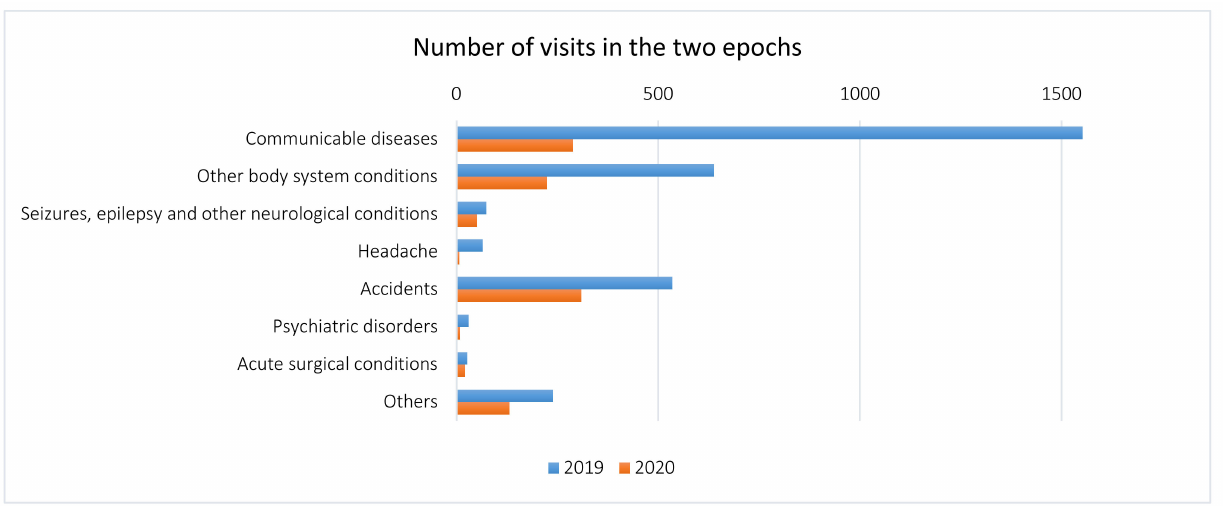
Figure 2. Distribution of diagnoses at discharge in the two study periods (March–April 2019 (non-COVID-19) vs. March– April 2020 (COVID-19)).